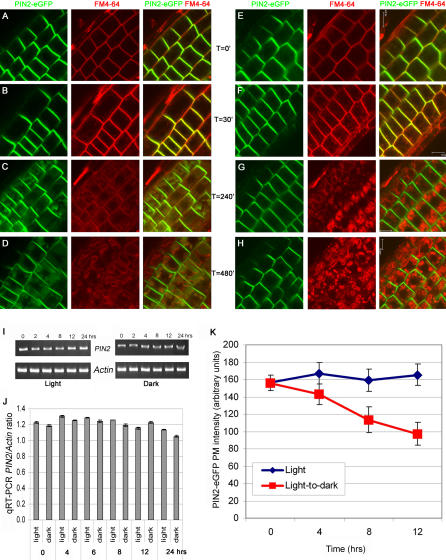
Time course of PIN2-eGFP vacuolar targeting.Five-day-old light-grown PIN2-eGFP seedlings were pulse-labeled with an endocytosis marker, FM4-64, and then transferred to dark (A–D) or kept in light (E–H). Both PIN2-eGFP (green) and FM4-64 (red) were restricted to the plasma membrane (PM) at T = 0 (A, E). At T = 30 min after transfer to dark, FM4-64 internalized to early endosomes and marked PIN2-eGFP-labeled endosomes (B). At T = 4 hrs after transfer to dark, PIN2-eGFP accumulated in vacuolar compartments, whose membrane was now labeled with FM4-64 (C). At T = 8 hrs after transfer to dark, strong vacuolar accumulation of PIN2-eGFP and FM4-64 labeling of vacuolar membrane were visible (D). On the other hand, FM4-64 labeled endosomes at T = 30 min (F) and vacuolar compartments at T = 4 and 8 hrs in seedling kept in the light condition (E–H). But, PIN2-eGFP remained at the PM under light (E–H). (A–H) Shown were root epidermal cells. Left, PIN2-eGFP (green); middle, FM4-64 (red); right, merged images. Scale bars, 10 µm. (I) RT-PCR analysis of steady state PIN2 transcript levels in seedlings grown in continuous light (left) or after light-to-dark transition (right) for up to 24 hrs. The steady state transcript levels of an Actin gene were used as internal loading controls. (J) Real-time qRT-PCR analysis of steady state PIN2 levels, normalized against the level of the Actin gene. Shown were the average PIN2/Actin ratios of three independent experiments. (K) Fluorescence intensities of PIN2-eGFP at the PM of root epidermis cells of light-grown plants kept in light (blue line) or shifted to dark (red line) for 0, 4, 8 and 12 hrs. Significant differences were observed between light- and dark-shifted plants at T = 4, 8 and 12 hrs (n = 168–466; Student's t-test, p<0.0001).